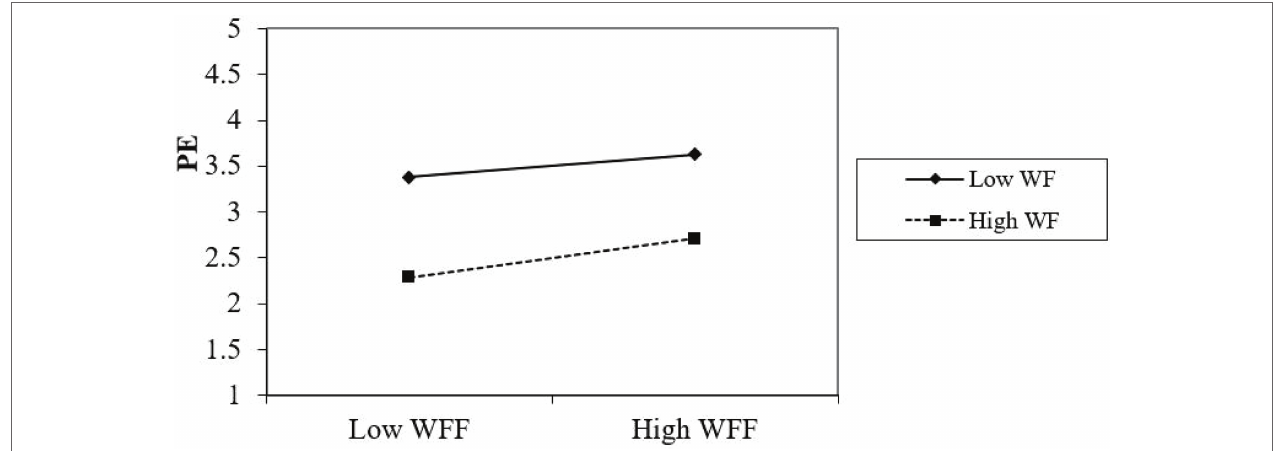
FIGURE 2 | The moderating role of work flexibility. WFF, work–family facilitation; WF, work flexibility; PE, positive emotions.